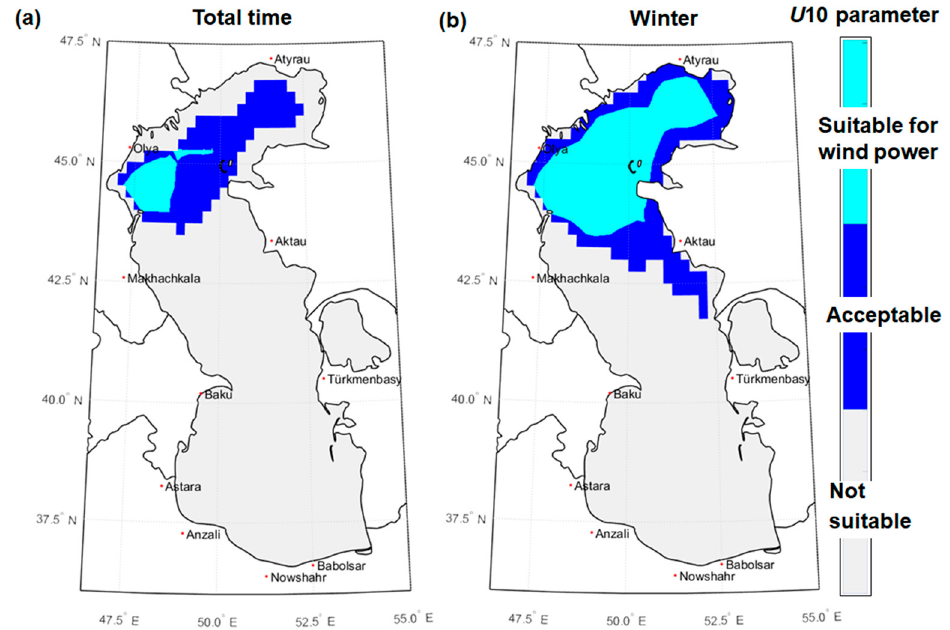
Figure 11. The suitability map for wind power with an average wind speed of 6 m / s as a reference. The results are indicated for: ( a ) full time distribution; ( b ) winter time.